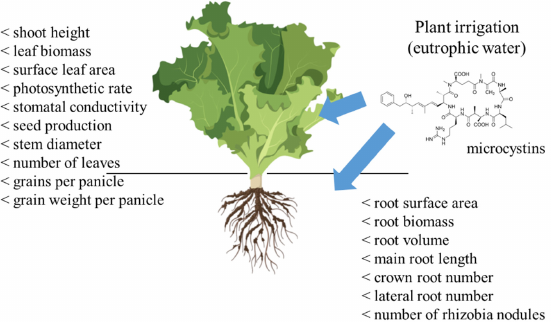
Figure 1. Main physiological and growth effects reported in agricultural plants irrigated or grown with microcystin (MC)-rich waters. Plant image is from BioRender (https://biorender.com/, accessed on February 2021).